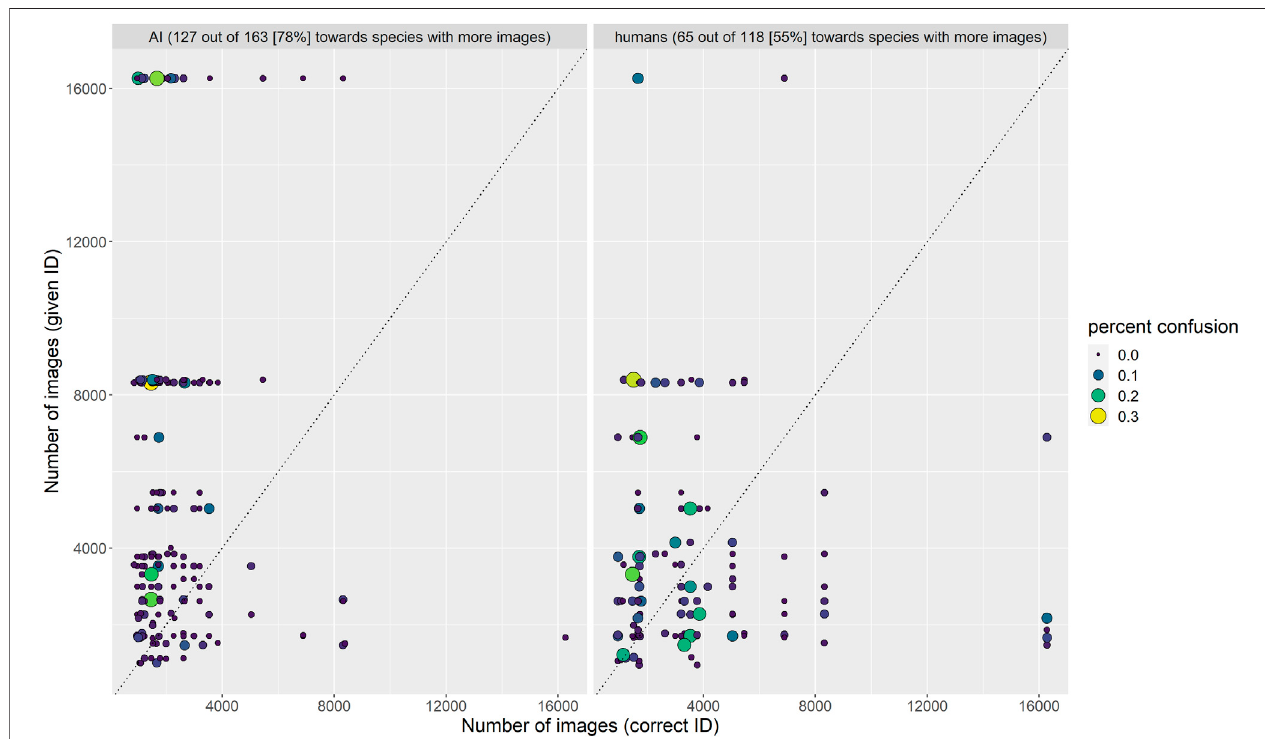
FIGURE 7 | Frequency with which confused species pairs were incorrectly identi fi ed by algorithm and humans. The algorithm erred on the side of the species with more training images much more often than humans.